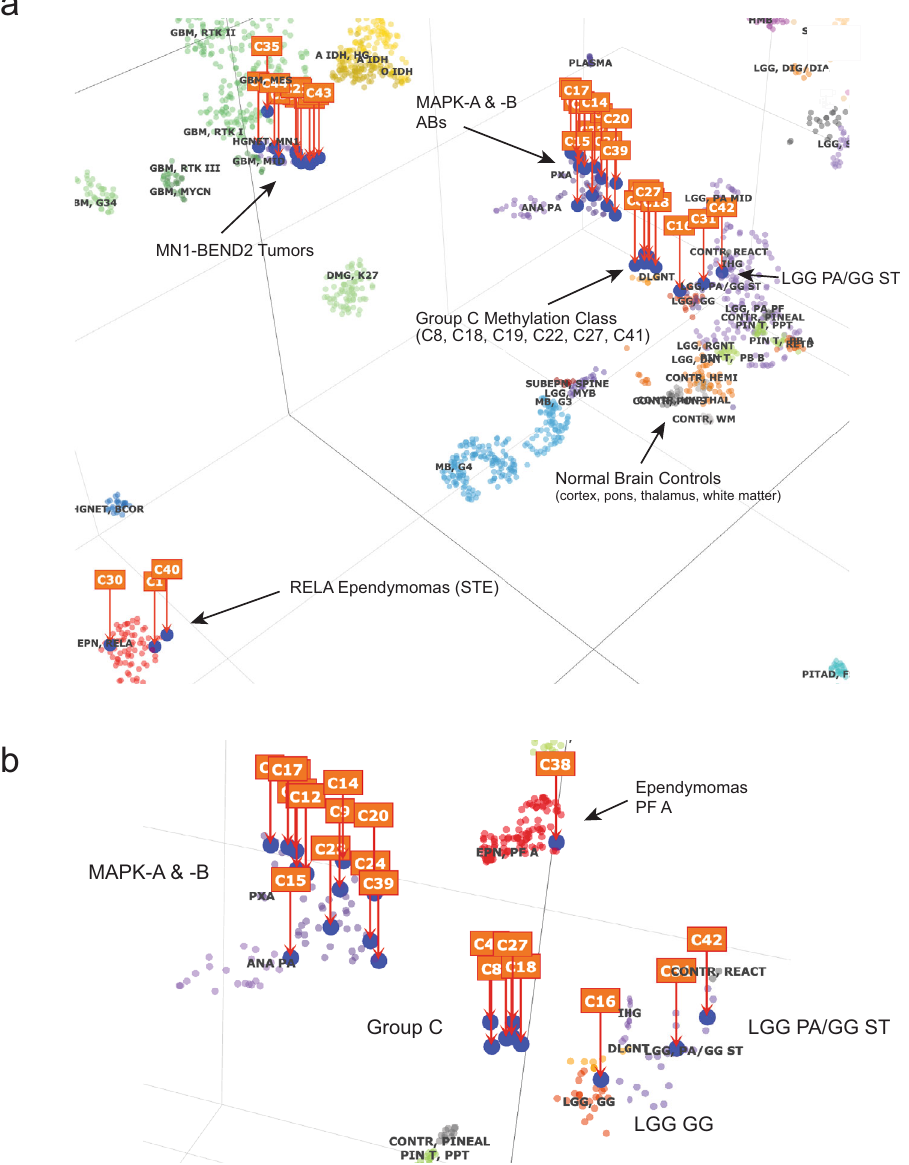
Fig. 3 Unsupervised tSNE analysis of genomic DNA methylation data reveals a distinct tumor DNA methylation class for Group C tumors. a 3-dimensional tSNE plot of all study samples with the German Cancer Center (DKFZ) reference sample set. b Enlargement of MAPK/PI3K (MAPK-A & -B) and Group C methylation classes. 32,000 methylation sites were used for the analyses. LGG ST PA/GG, low-grade glioma, supratentorial pilocytic astrocytoma/ ganglioglioma (nonspeci fi c methylation class); LGG GG, low-grade glioma, ganglioglioma methylation class. Source data: GEO GSE125450 and